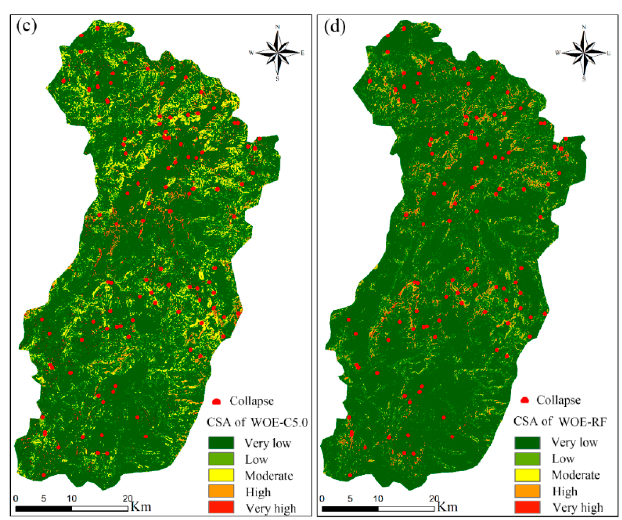
Figure 7. Collapse susceptibility maps of ( a ) weight of evidence (WOE)-Analytic Hierarchy Process (AHP), ( b ) WOE-Multiple Linear Regression (MLR), ( c ) WOE-C5.0 and ( d ) WOE-Random Forest (RF). Remote Sens. 2020 , 12 , x FOR PEER REVIEW